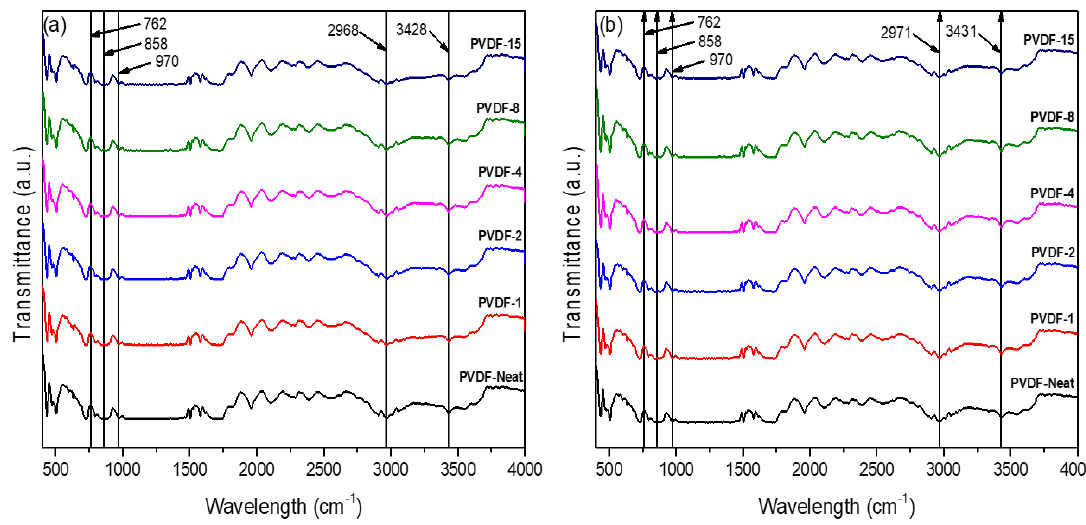
Figure 5. FTIR spectra of neat and embedded membranes at exposure periods of ( a ) 7 days (representing the minimum exposure period) and ( b ) 112 days (representing the maximum exposure period).